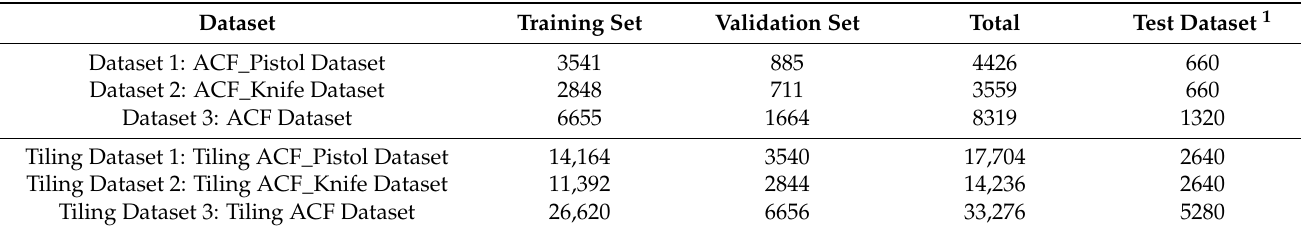
Table 4. Dataset